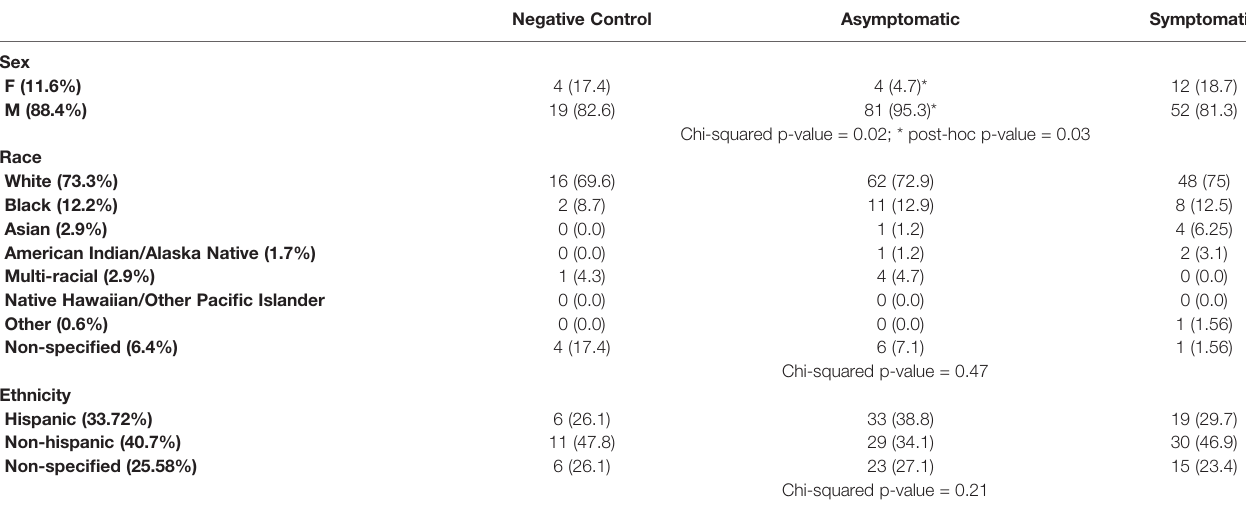
Negative Control Asymptomatic Symptomatic